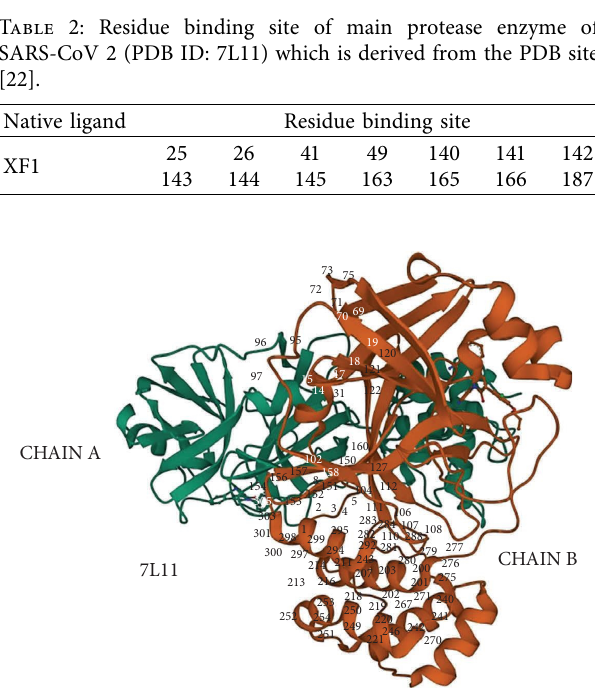
Figure 1: Residue binding site of protease enzyme of SARS-CoV 2 (PDB ID: